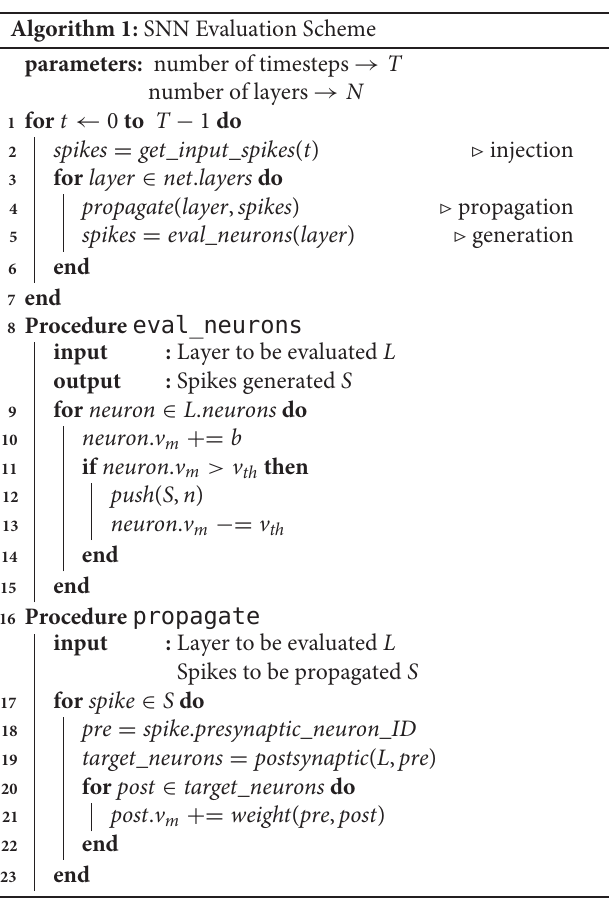
Algorithm 1: SNN Evaluation